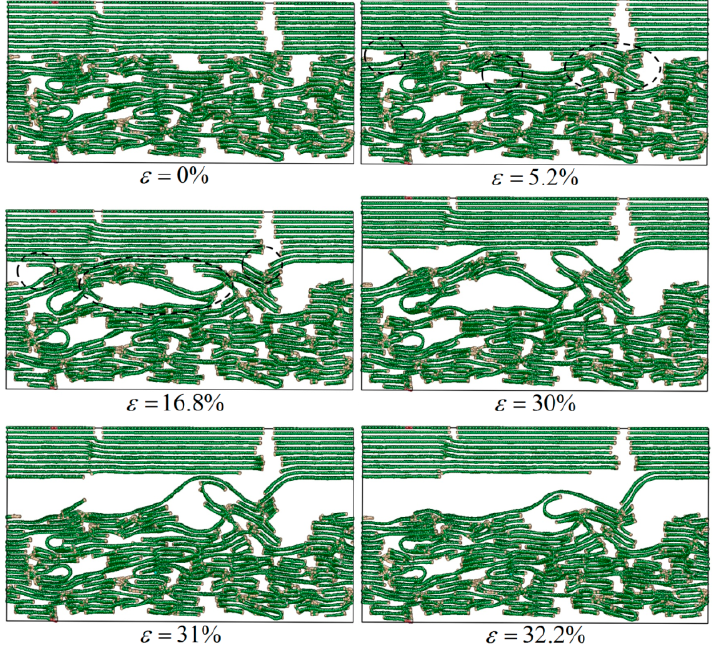
Figure 8. Typical failure modes of the C f /PyC interphase under a normal tensile load when L a = 10 nm